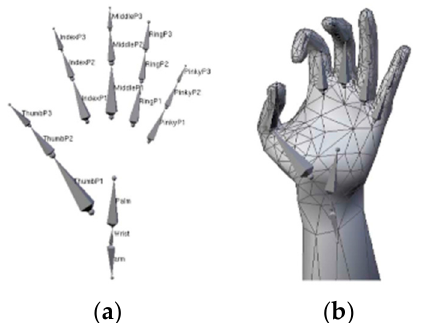
Figure 8. Hand model composed of meshes. ( a ) The skeleton. ( b ) The deformed hand triangulated surface [55].